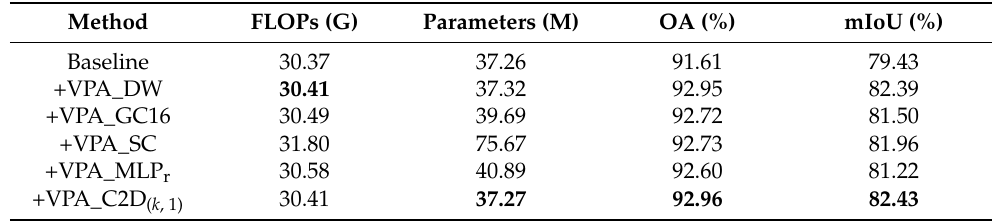
Table 1. Comparison of VPA achieved by different weight learning methods. The bold indicates the best